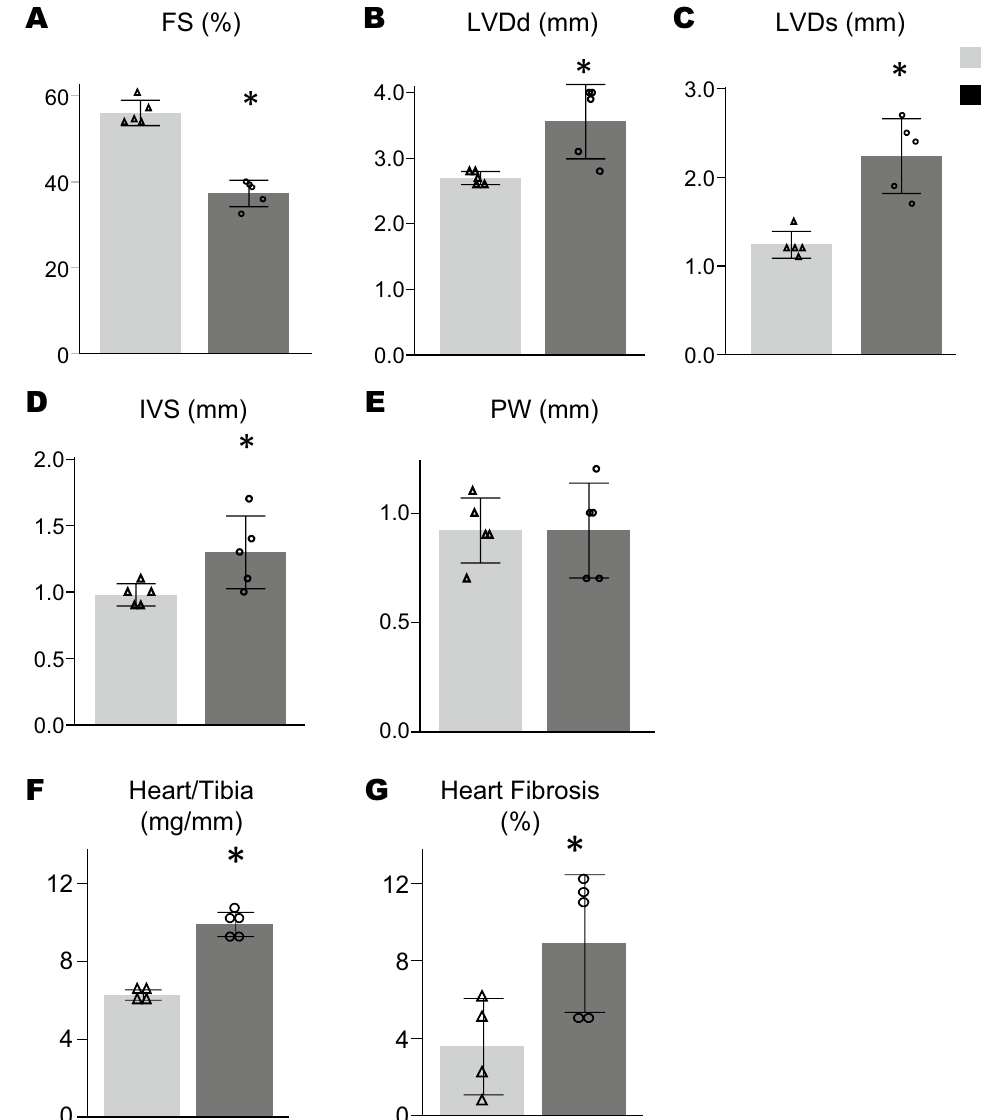
Figure 2. Characteristics of TAC mice. This Figure shows ( A–E ) the echocardiogram result, ( F ) the weight of heart measured as heart/tibia ratio, and ( G ) the area of heart fibrosis. The echocardiogram revealed that TAC mice had reduced fractional shorting ( A ), larger left ventricular end-diastolic and end-systolic diameter (LVDd, LVDs) and thickened interventricular septum (IVS) ( B–D ). Significant differences were observed in heart weight and fibrosis between the TAC mice and the non-TAC mice ( F,G ). *p < 0.05. Gray bar and open triangle, non-TAC mice; black bar and open circle, TAC mice. All graphs were created using JMP 14.0 software (SAS Institute Inc., Cary,